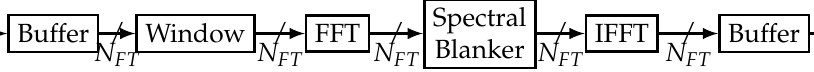
Figure 2. Block diagram for FDAF. ©IEEE. Reprinted, with permission, from